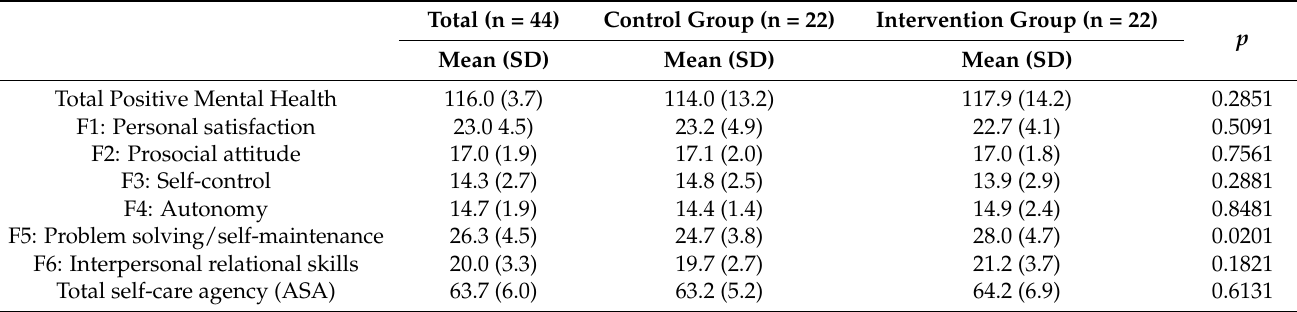
Table 2. Comparison of PMH and self-care at baseline.